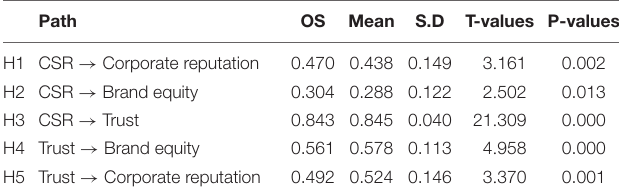
TABLE 7 | Path model results (direct and